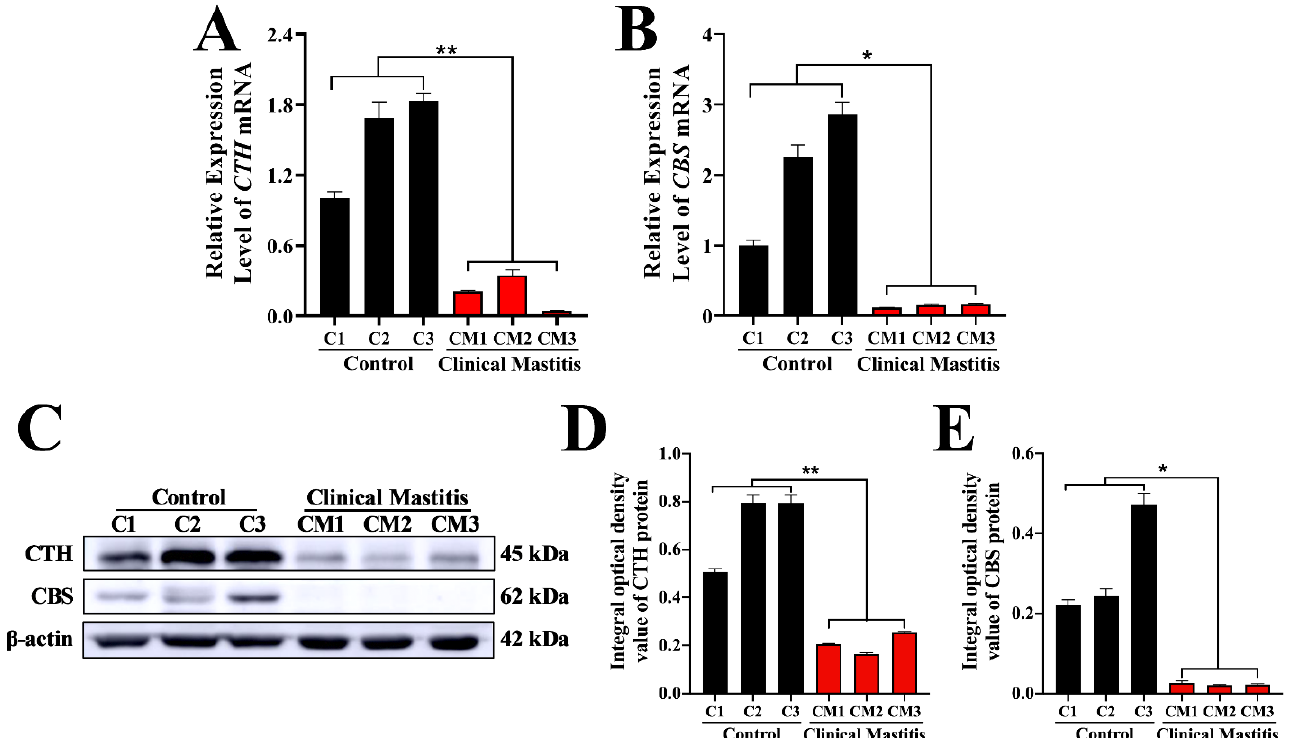
Figure 5. Relative expression levels of CBS and CTH mRNA and proteins in the mammary glands. ( A , B ) Expression levels of CBS and CTH mRNA in the mammary glands of the C and CM groups. GAPDH mRNA was used as the internal control. ( C ) Western blot analysis of CBS, CTH, and β -actin proteins in the mammary glands of the C and CM groups. ( D , E ) Relative integral optical density of CBS and CTH in the mammary glands of the C and CM groups. C, represents control. CM, represents clinical mastitis. The data were analyzed by Student’s t-test (between two groups) or one-way ANOVA analysis (within multiple groups), and expressed as mean ± SEM. * represents p < 0.05 and ** represents p < 0.01.